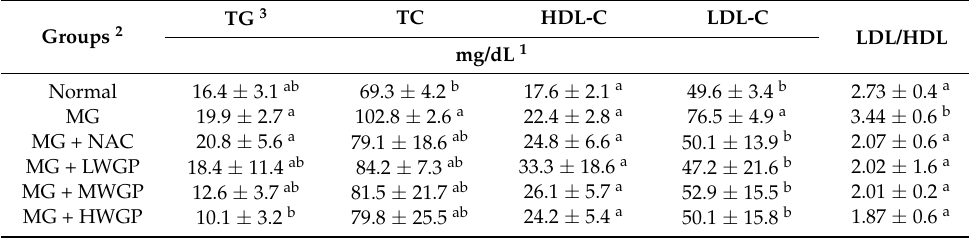
Table 2. Effects of WGP on serum TG, TC, HDL-C, and LDL-C in MG-treated rats.